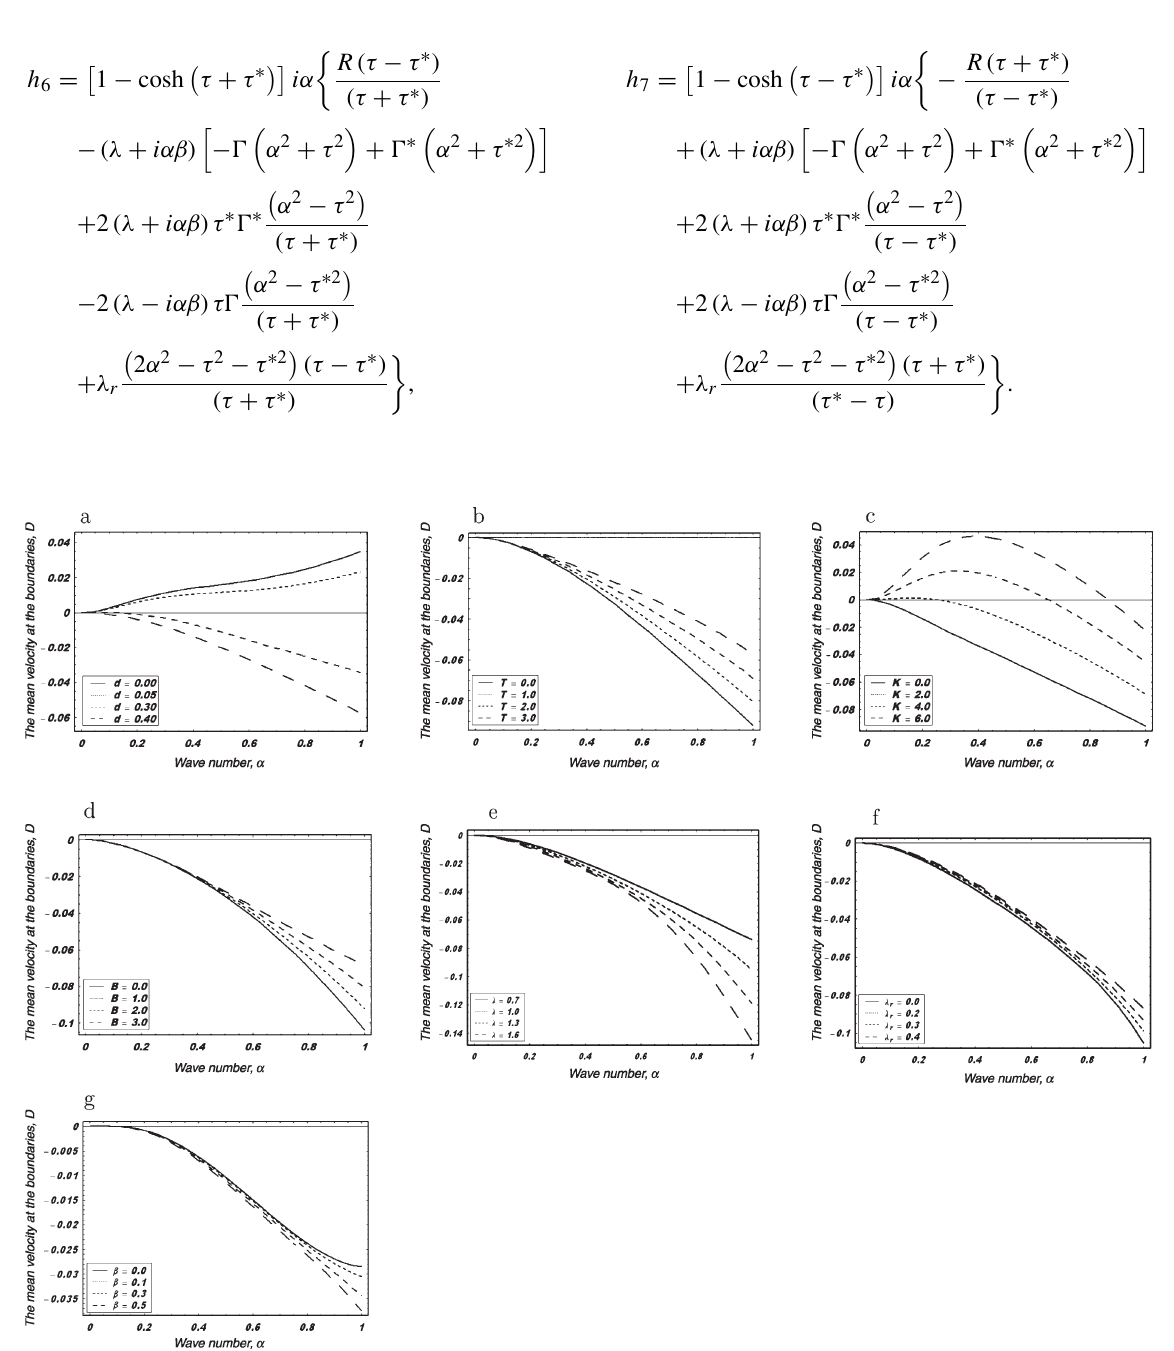
Fig. 1. The variation of D with wave number α for four different values of wall damping d (panel( a )), wall tension T (panel( b )), spring stiffness K (panel( c )), flexural rigidity B (panel( d )), relaxation time λ (panel( e )), retardation time λ r (panel( f )) and Burgers’ fluid parameter β (panel( g )). The other parameters chosen are m = 0 . 01, B = 2, T = 1, K = 1, R = 10, λ = 0 . 8, λ r = 0 . 5 and β = 0 . 3 (panel( a )); m = 0 . 01, B = 2, K = 1, R = 10, d = 0 . 5, λ = 0 . 8, λ r = 0 . 5 and β = 0 . 3 (panel( b )); m = 0 . 01, B = 2, T = 1, R = 10, d = 0 . 5, λ = 0 . 8, λ r = 0 . 5 and β = 0 . 3 (panel( c )); m = 0 . 01, T = 1, K = 1, R = 10, d = 0 . 5, λ = 0 . 8, λ r = 0 . 5 and β = 0 . 3 (panel( d )); m = 0 . 01, B = 2, T = 1, K = 1, R = 10, d = 0 . 5, λ r = 0 . 5 and β = 0 . 3 (panel( e )); m = 0 . 01, B = 2, T = 1, K = 1, R = 10, d = 0 . 5, λ = 0 . 8 and β = 0 . 3 (panel( f )) and m = 0 . 01, d = 0 . 3, B = 2, T = 1, K = 1, R = 10, λ = 0 . 8 and λ r = 0 . 5 (panel( g ))